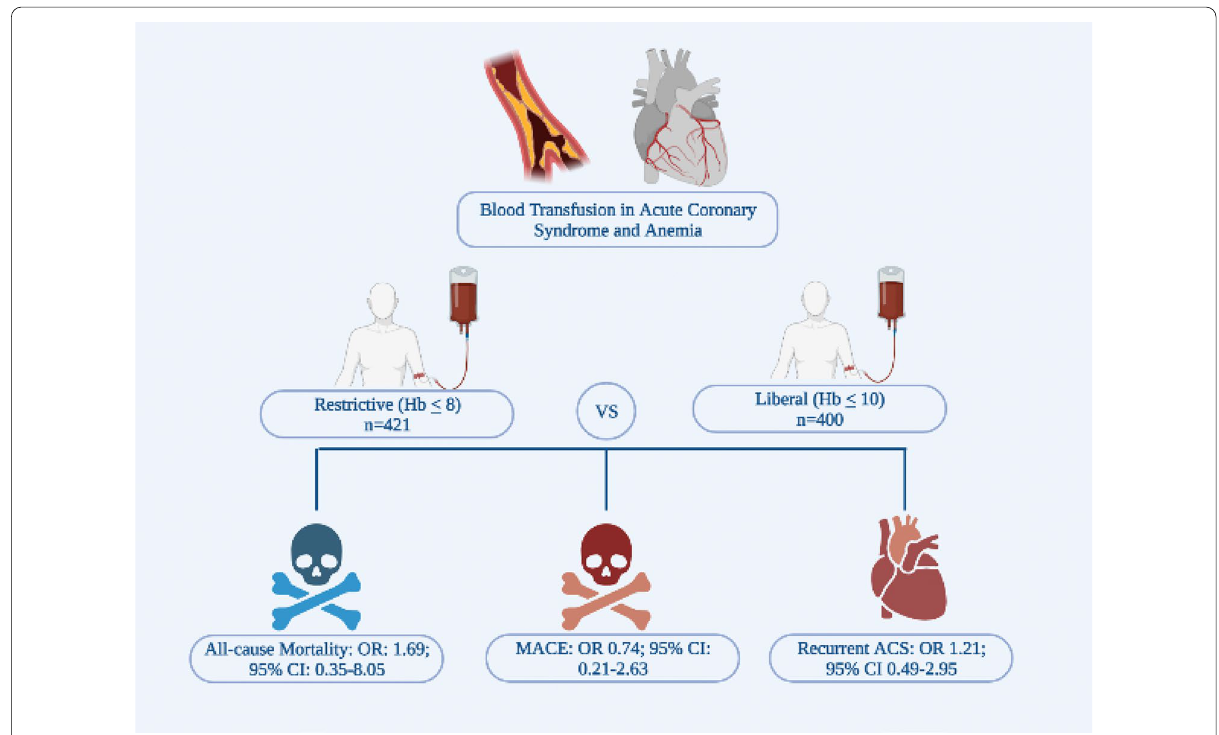
Fig. 5 Graphical abstract. OR odds ratio, Hb